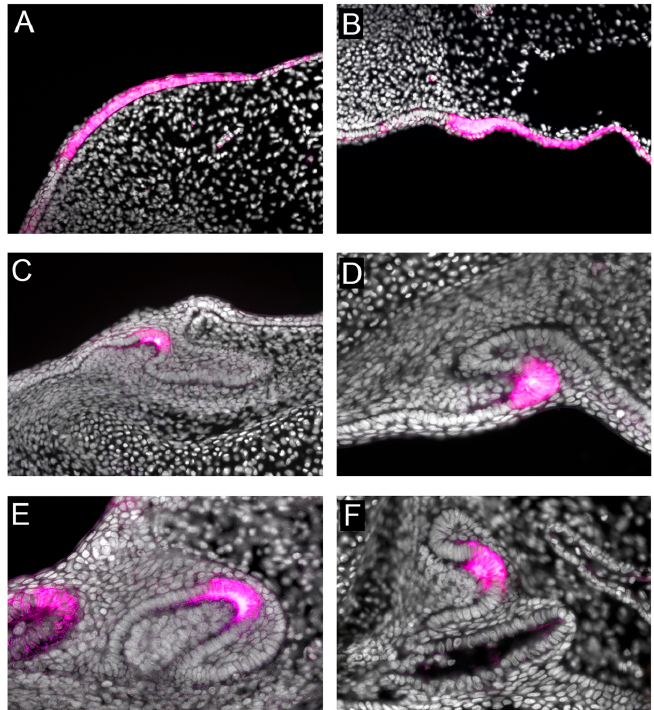
Figure 4. Conserved shh expression in shark tooth initiation and successional morphogenesis. Expression of shh in the odontogenic band marks the onset of dental competence in the shark ( Scyliorhinus stellaris ) lower jaw ( A ) and upper jaw ( B ). Development of the first tooth and subsequent morphogenesis in Scyliorhinus canicula is superficial with shh expression restricted to the dental epithelium at the apical cusp, lower jaw ( C ) and upper jaw ( D ). Dental lamina epithelium continues to invaginate lingual to the first tooth, from which new successional teeth will develop in the lower jaw ( E ) and upper jaw ( F ). New successional teeth in the shark continue to express shh during morphogenesis ( E , F ). Note shh is not expressed in the epithelial dental lamina away from developing teeth, and its expression is restricted to the enamel knot-like cells at the apex of each new tooth throughout morphogenesis. False colour, (magenta) gene expression; nuclear counterstain DAPI (white).